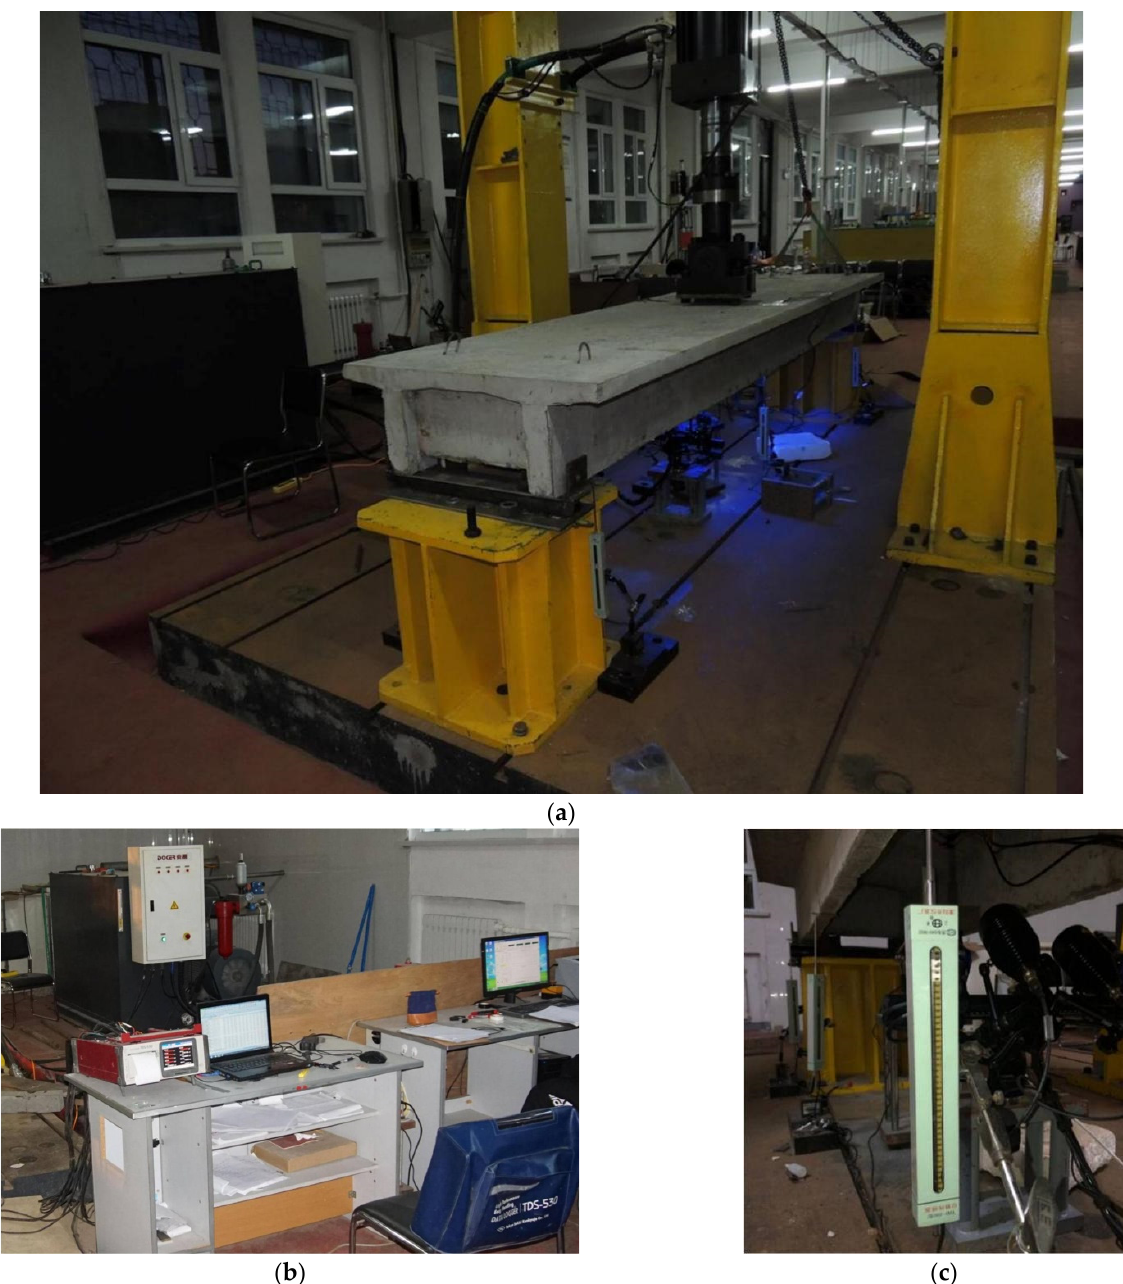
Figure 6. Fatigue test loading of test beam ( a ) Loading device, ( b ) Control System, and ( c ) Displacement test systems.